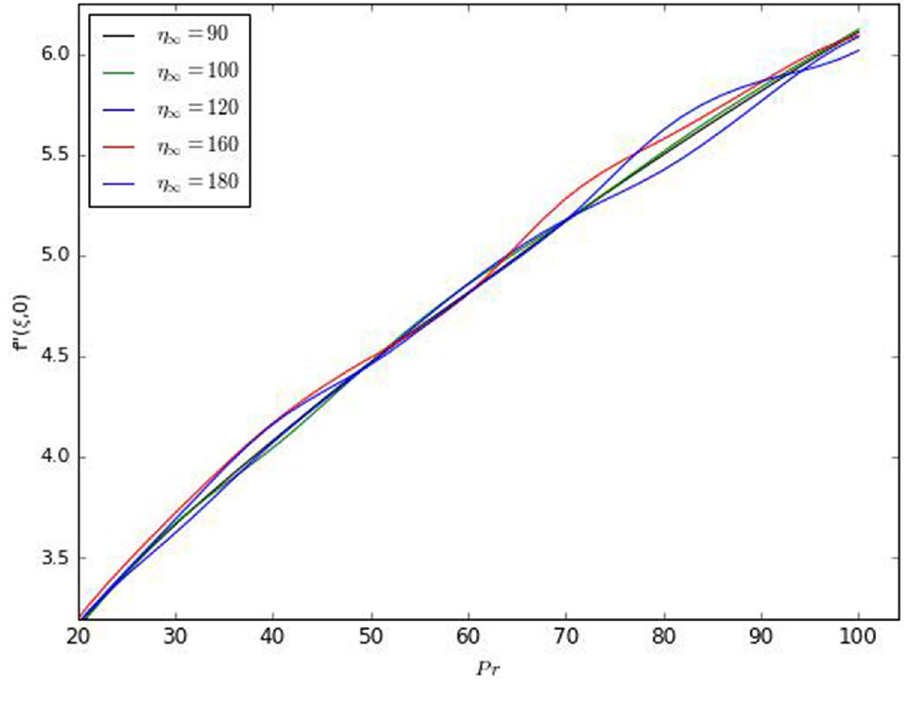
Fig. 3 Temperature profile for different 𝜂